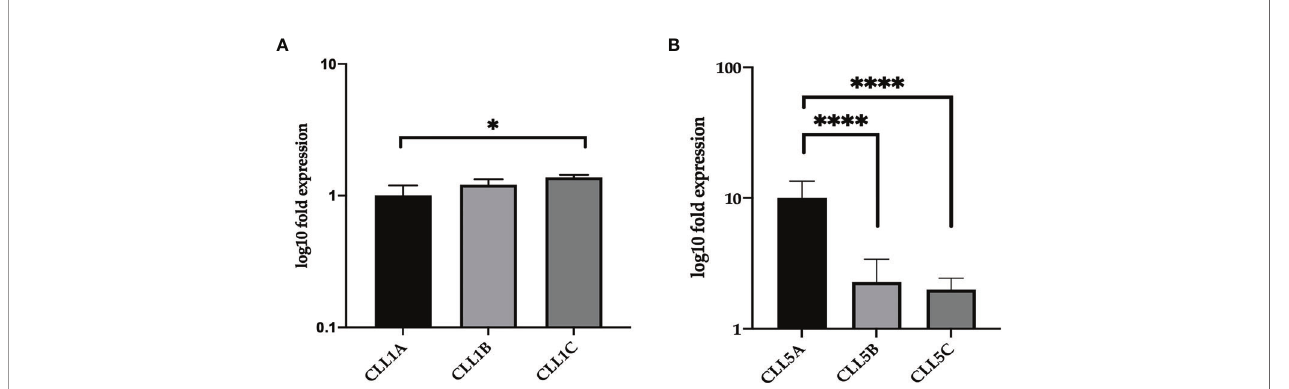
FIGURE 1 | Relative expression of CD5 in CLL clones of CLL1 and CLL5 patients. Relative CD5 gene expression in total B-CLL cells from CLL1 (A) and CLL5 (B) patient. The results were normalized to the GAPDH housekeeping gene, determined by DD Ct method, and represented as log10 fold expression ± SD of triplicate assessments. Statistical signi fi cance was evaluated using one-way analysis of variance (ANOVA), followed by Bonferroni ’ s test for multiple comparisons. Bars show mean values±95% con fi dence intervals based on three biological replications. *P ≤ 0.01; ****P ≤